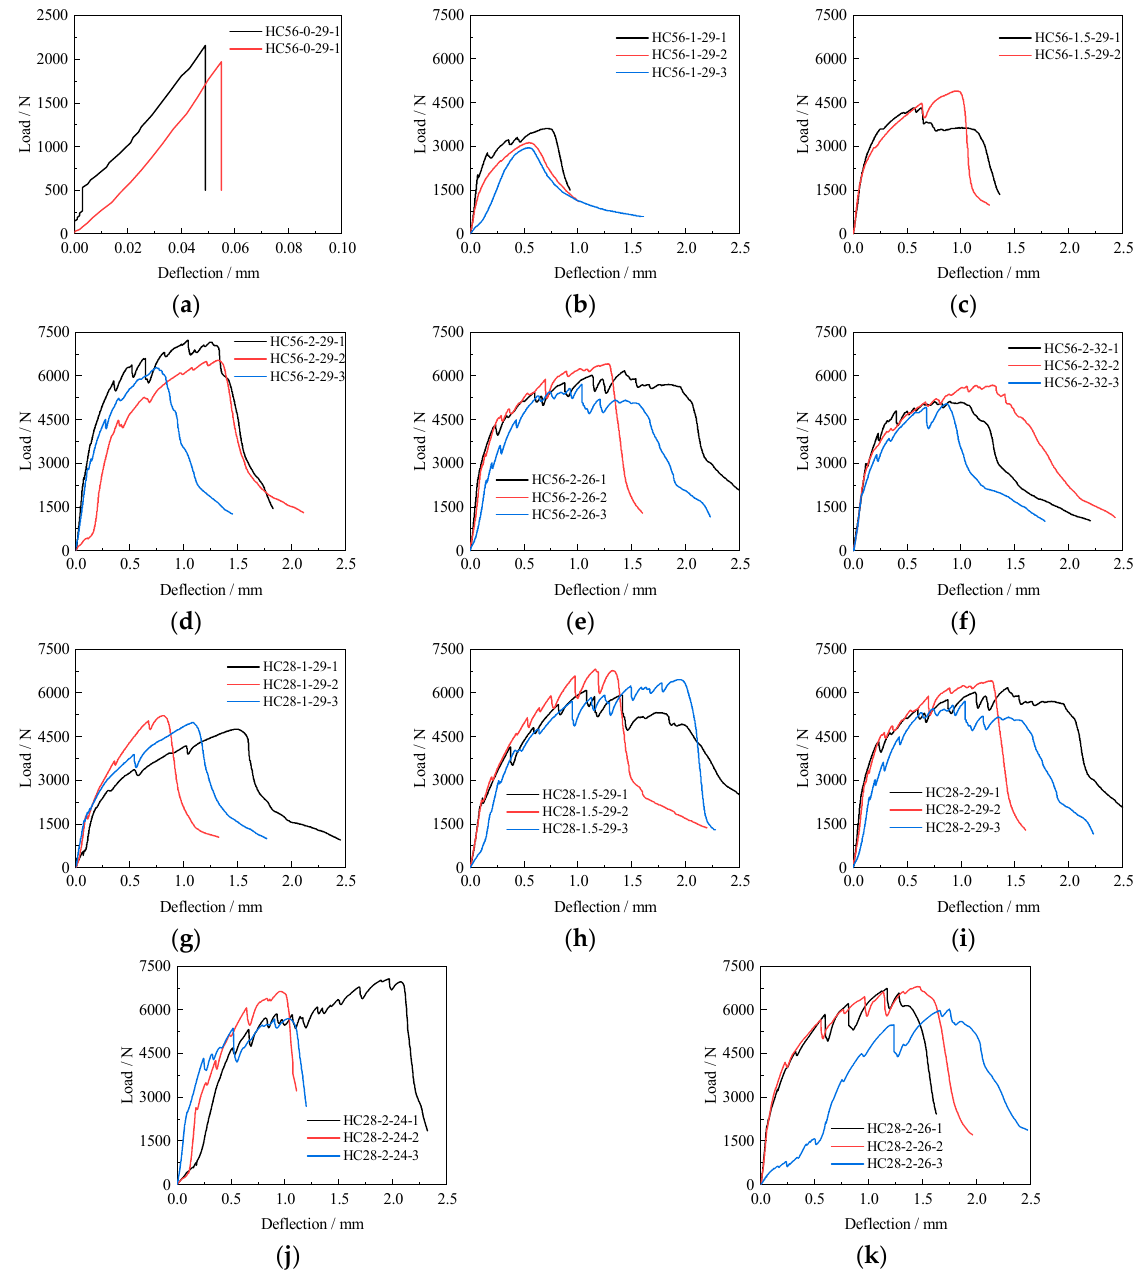
Figure 6. Load-deflection curves: ( a ) HC56-0-29; ( b ) HC56-1-29; ( c ) HC56-1.5-29; ( d ) HC56-2-29; ( e ) HC56-2-26; ( f ) HC56-2-32; ( g ) HC28-1-29; ( h ) HC28-1.5-29; ( i ) HC28-2-29; ( j ) HC28-2-24; ( k ) HC28-2-26.